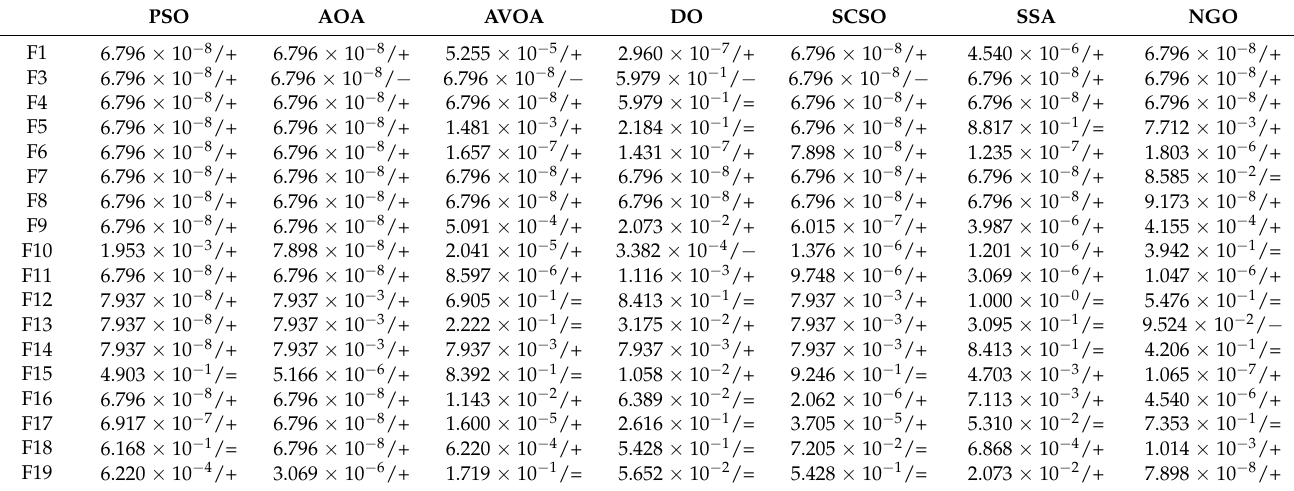
Figure 8. The radar maps of the different algorithms on CEC2017. Table 3. The p -value of Wilcoxon rank sum test between the ENGO and other algorithms.